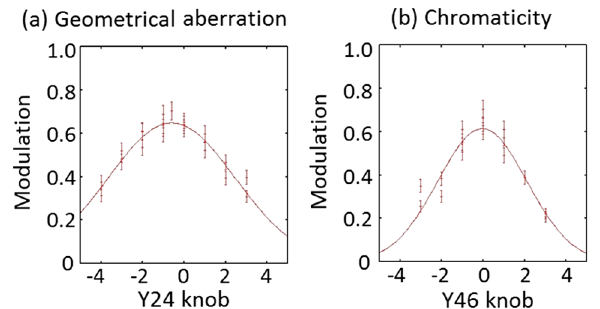
FIG. 12. Example use of nonlinear knobs utilizing strength changes of normal sextupole magnets in the final focus beam line. The beam size tuning was done with IP-BSM 30°